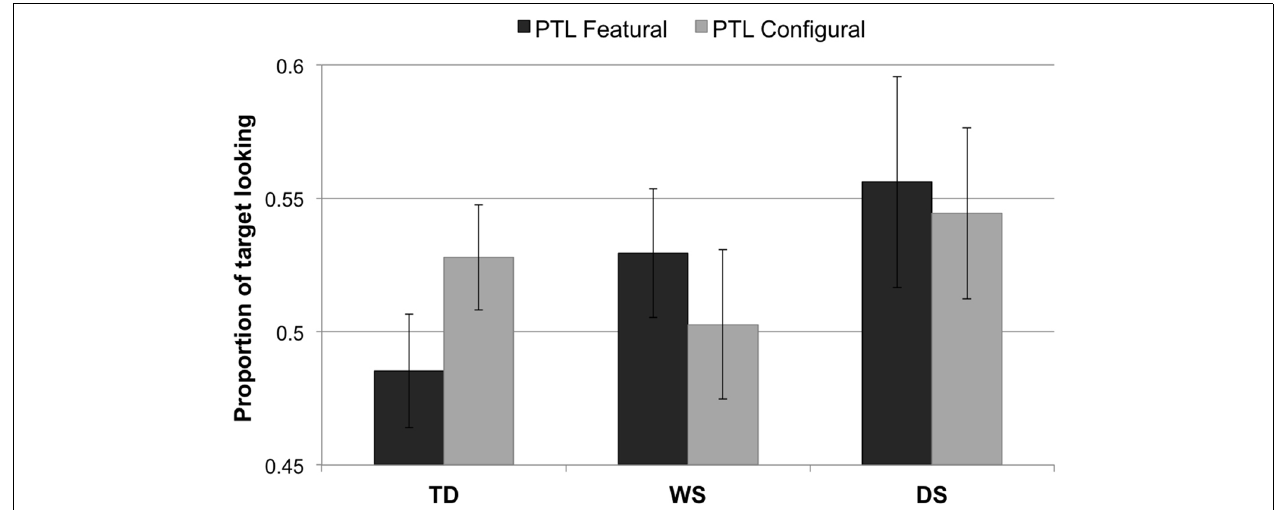
FIGURE 3 | Proportion of target looking for each condition (featural, configural) and group (TD controls, Williams syndrome, Down syndrome). A PTL above 0.5 indicates longer